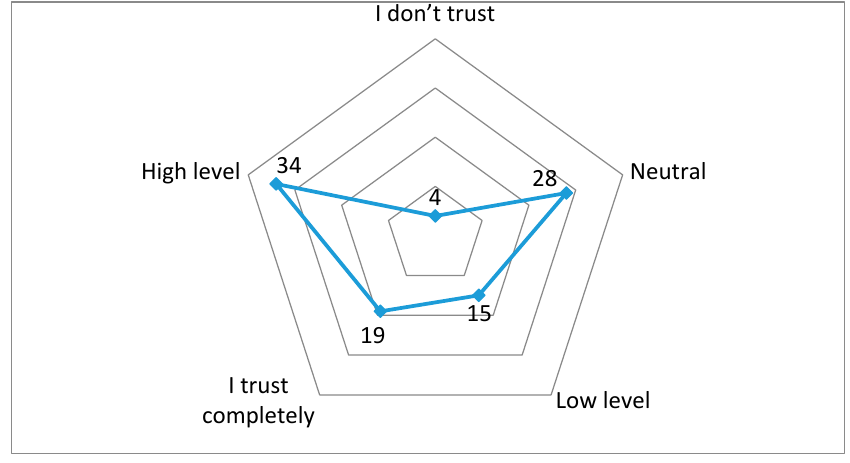
Figure 2. Trust in vaccines.